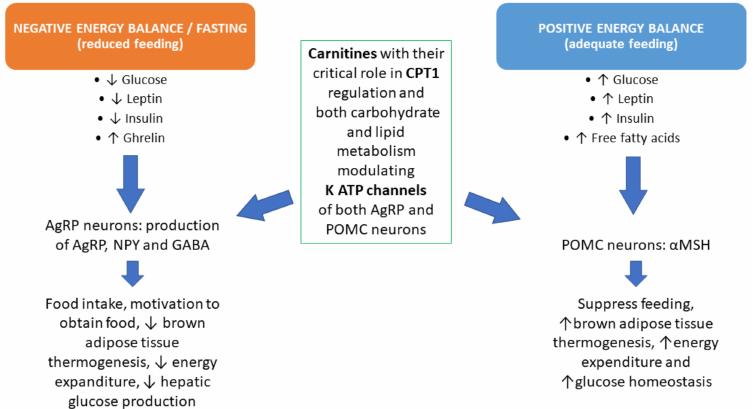
Figure 4. Feeding and related metabolic events are able to modulate hormones and neuropeptides. Normal feeding ( right ) or reduced feeding ( left ) act specifically through the activation of tissues and organs to compensate for any metabolic excess or deficiency. Carnitine integration permits specific modulations on most of these metabolic pathways through CPT1 regulation. CPT1 : Carnitine Palmitoyl-Transferase 1; AgRP : Agouti-Related Protein; NPY : NeuroPeptide Y; GABA : Gamma Amino-Butyric Acid; POMC : Pro-Opio-Melano-Cortin; MSH : Melanocyte Stimulating